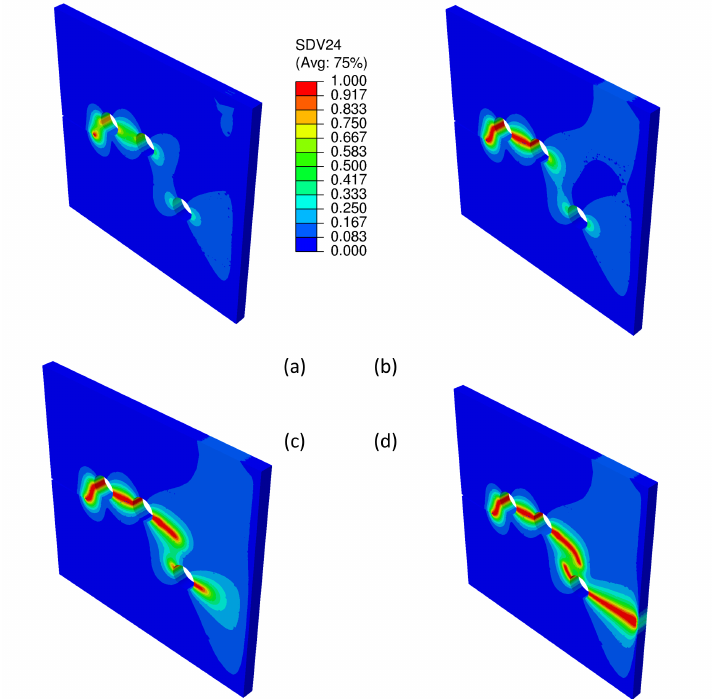
Figure 12. Crack propagation steps for lower incremental step size: ( a ) crack propagation after 100 steps ( b ) crack propagation through holes; ( c ) deflected path due to damage zone influence of hole below; and ( d ) crack initiates at the stress concentration zone and